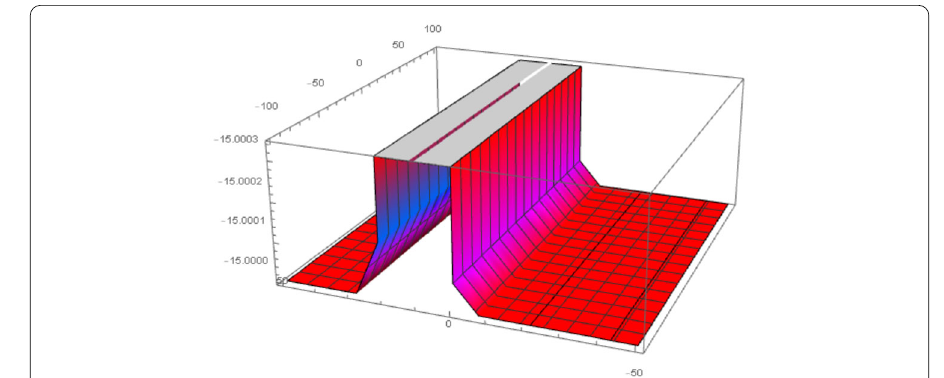
Figure 4 Solitary wave solution of u 4 ( η ) for α = 0.75, a 1 = 1, λ = –1, V = 0, b 1 = 1